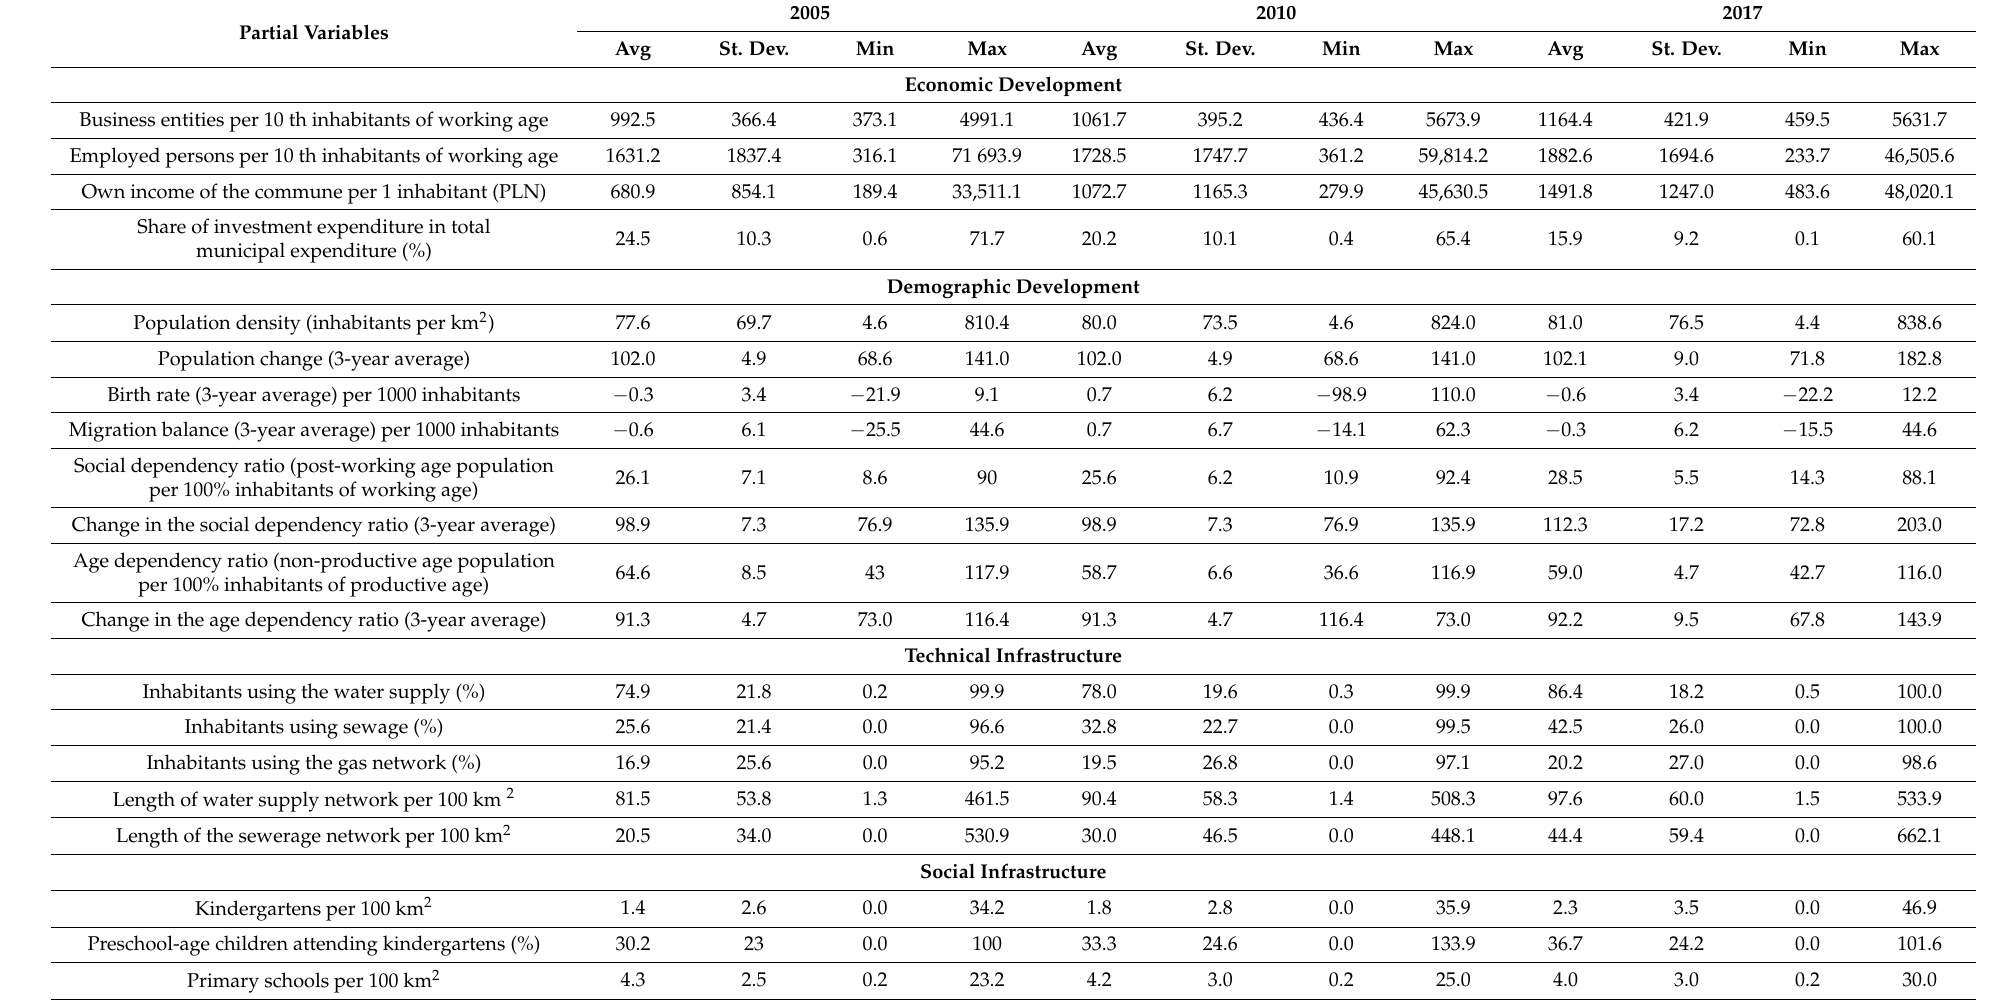
Table 2. Descriptive statistics of one-dimensional variables describing particular partial development